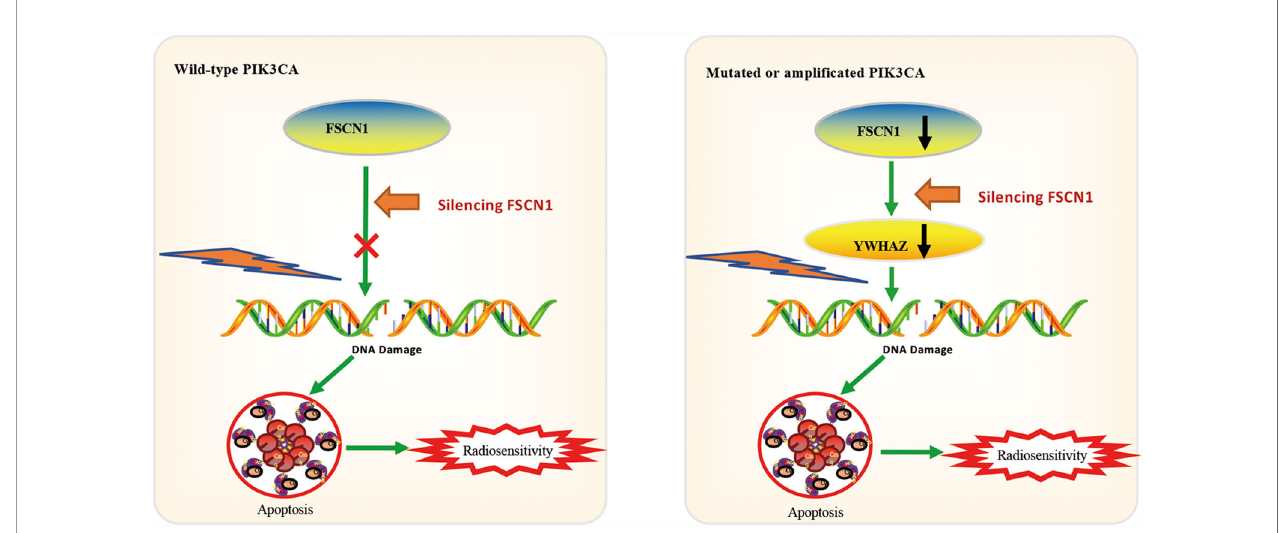
FIGURE 5 | Model of mechanisms of FSCN1 in PIK3CA-altered tumor